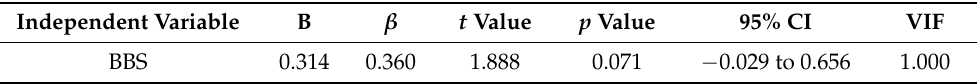
Table A3. Dependent variable: Leg extension angle on the non-affected side. Independent variable: BBS, FMA-LL, MI-LL, leg extension angle on the affected side.